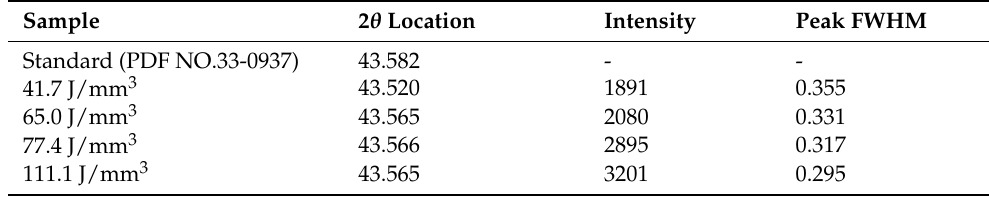
Table 3. XRD data showing the 2 θ values, intensity, and peak FWHM of the main peaks. Sample 2 θ